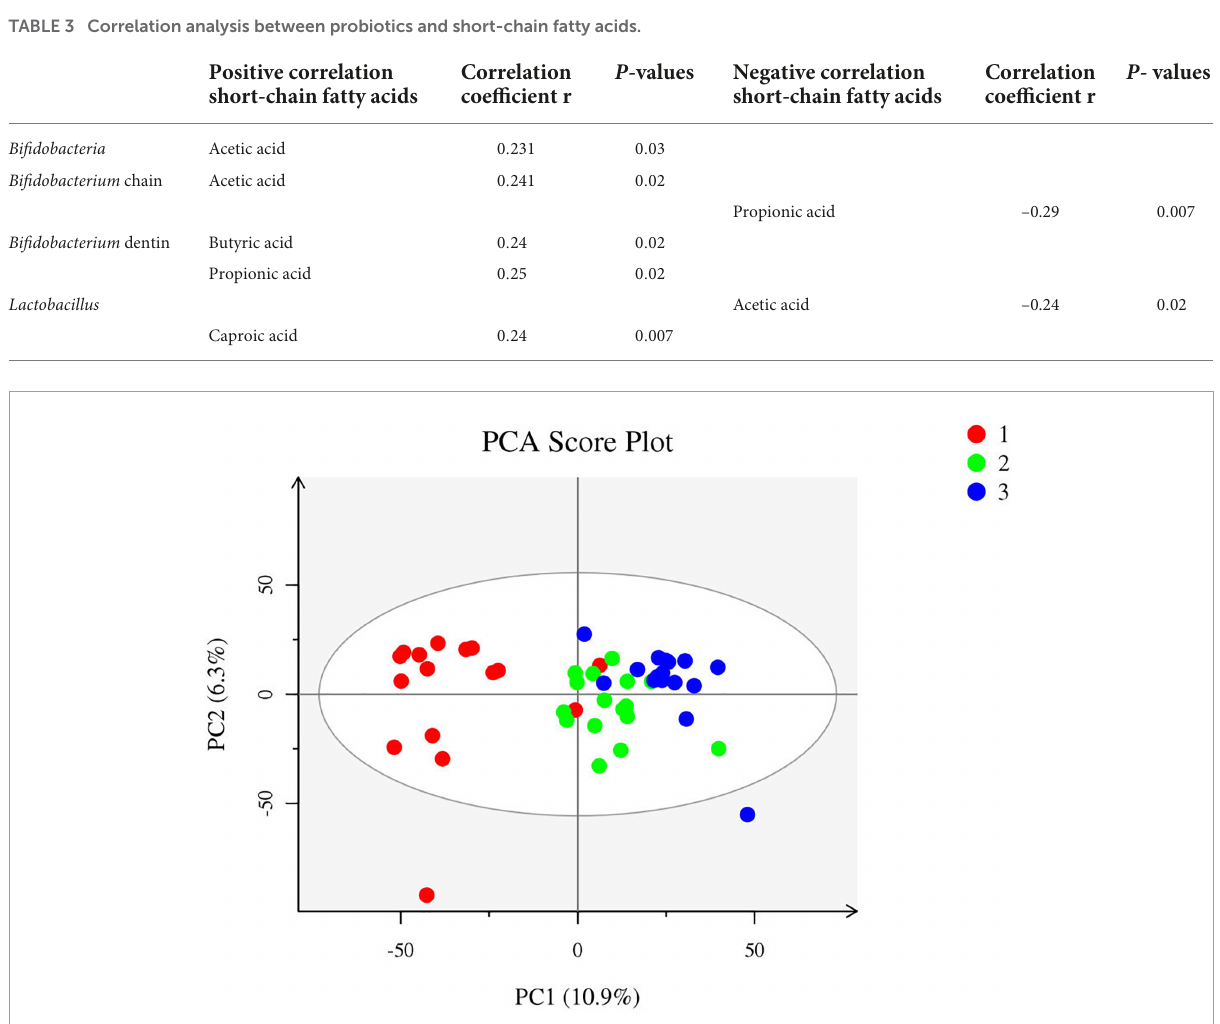
FIGURE5 Metabolites with the significant difference in different phototherapy times (1, 2, and 3 represent before phototherapy, 24 h after phototherapy, and 48 h after phototherapy,